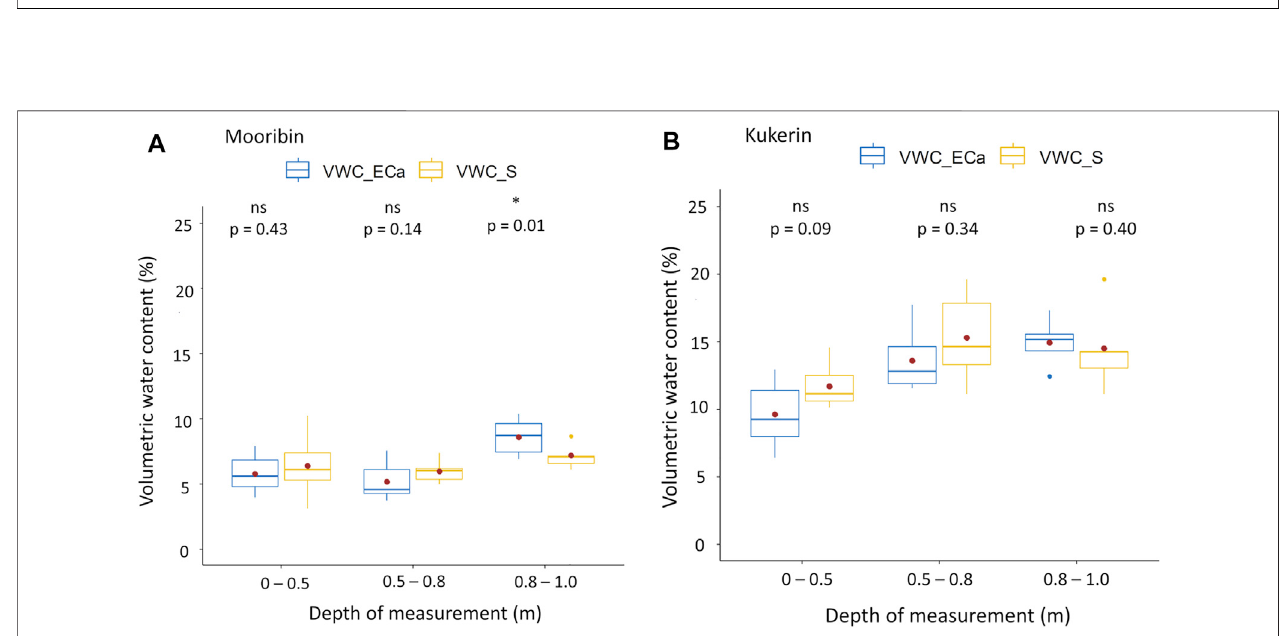
FIGURE 5 | Comparison of measured volumetric water content (%) from soil samples (VWC_S) vs. predicted volumetric water content using ERT – EMI calibration curves (VWC_ECa) from inverted EC of the wet season (both taken in August 2019) (A) at Mooribin (B) at Kukerin site. Whiskers indicate the maximum and minimum values at the 95% con fi dence level, the top and bottom of the box show the 25th and 75th percentiles, the line inside the box is the median value, the dot inside is the mean value, and p values are determined using Wilcoxon test.